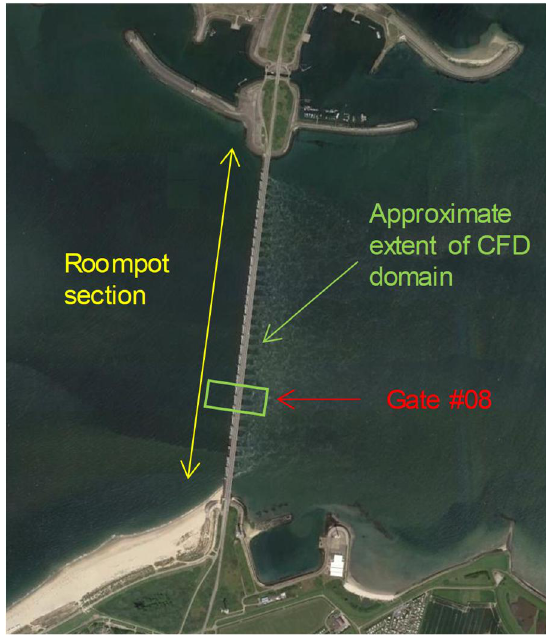
Fig. 2. Detail image of the Roompot section with the location of Gate#08 (in red) and the approximate extent of the CFD domain (in green)